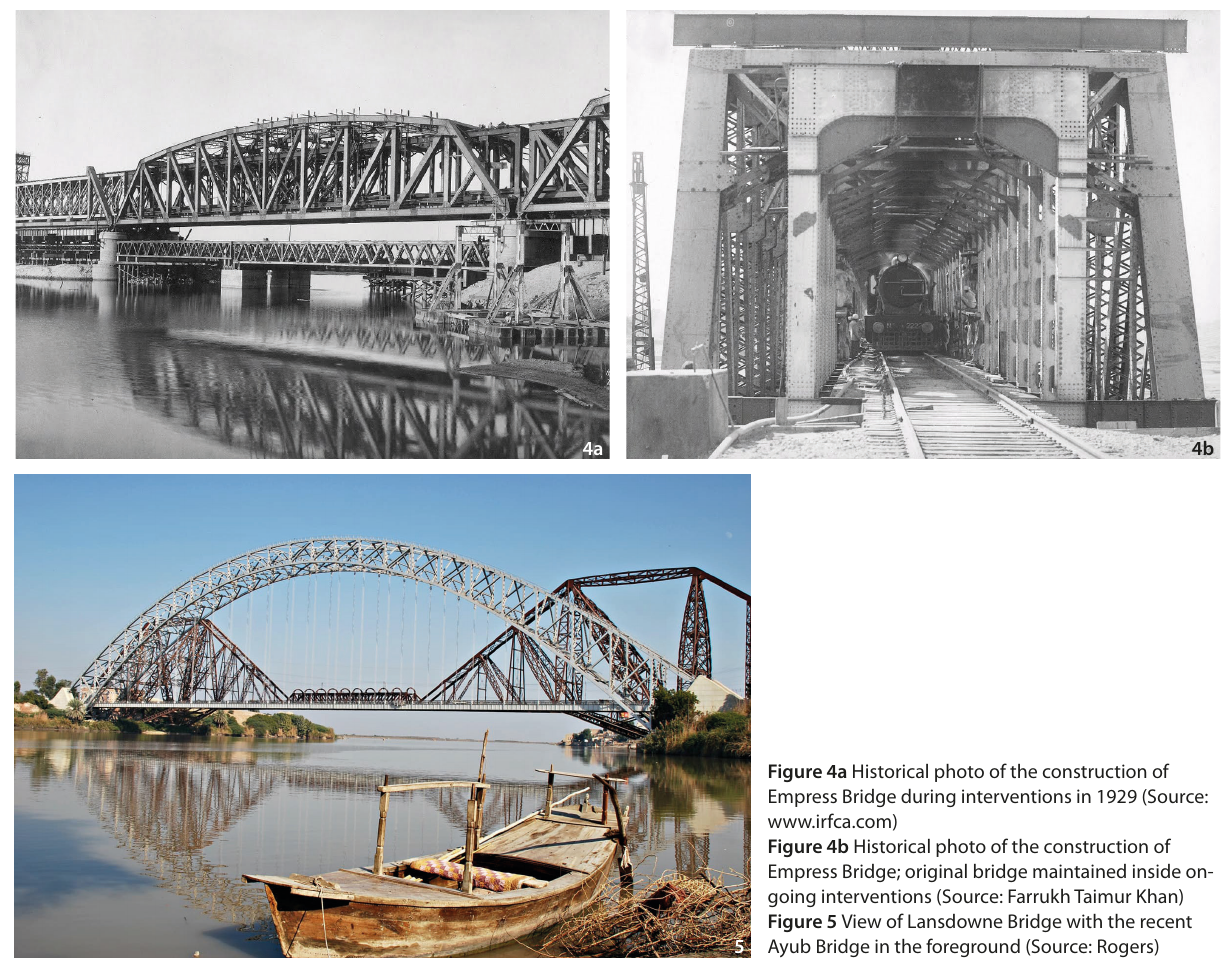
Figure 4a Historical photo of the construction of Empress Bridge during interventions in 1929